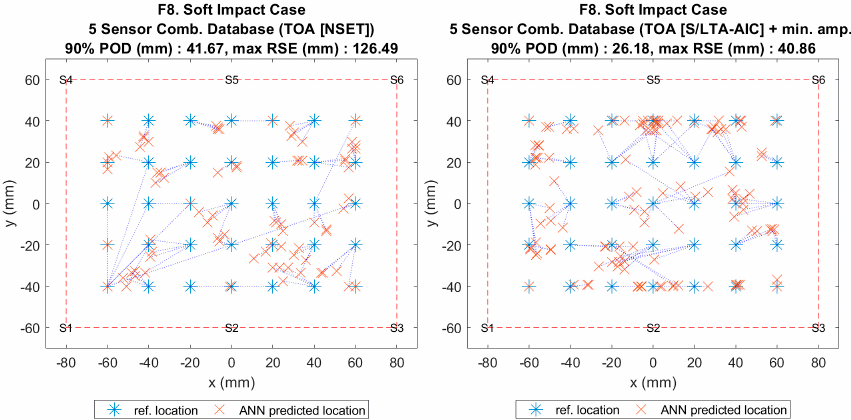
Figure 13. Visualisation of impact localisation for soft impacts (F8) using di ff erent input features: NSET extracted ToA ( left ) and S / LTA-AIC extracted ToA with normalized minimum amplitude ( right